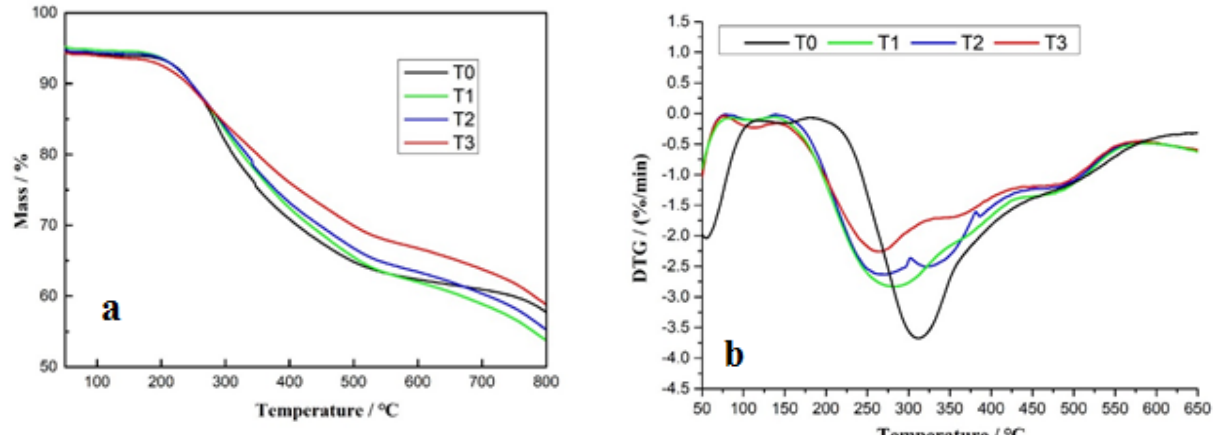
Figure 2. TMA curve of the highly branched polymer-modified tannin resin.